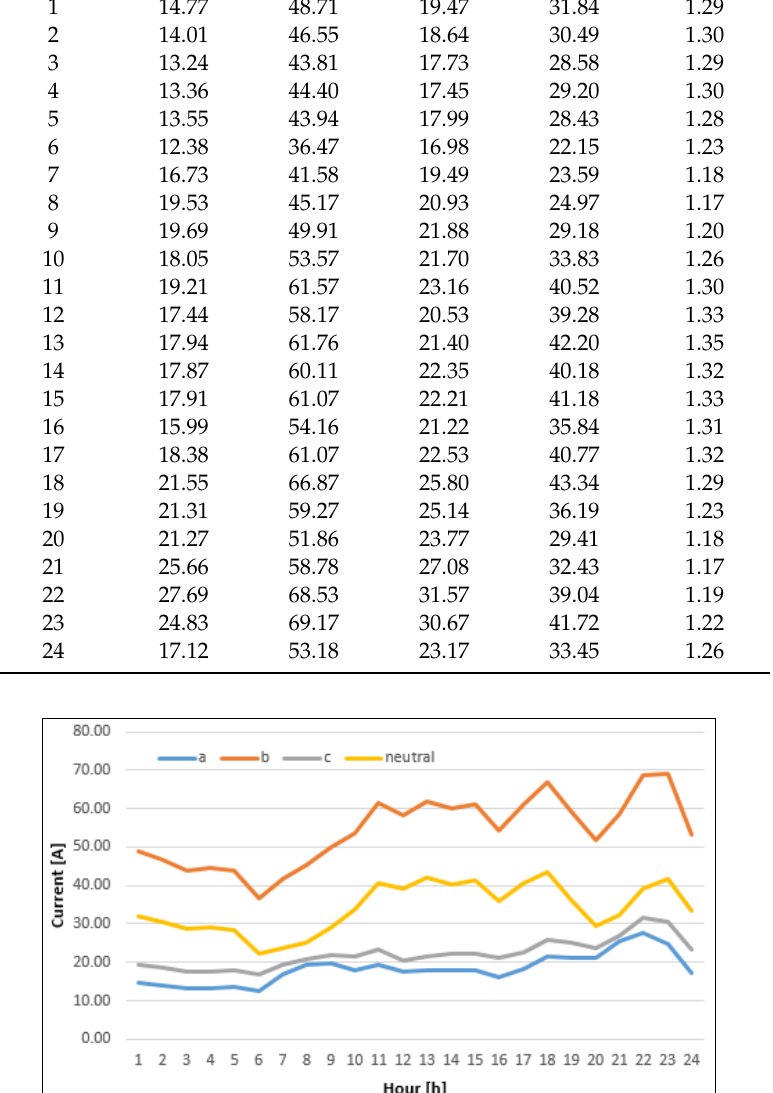
Figure 9. The currents in the conductors of the first branch, SP—Pillar 8, initial case.